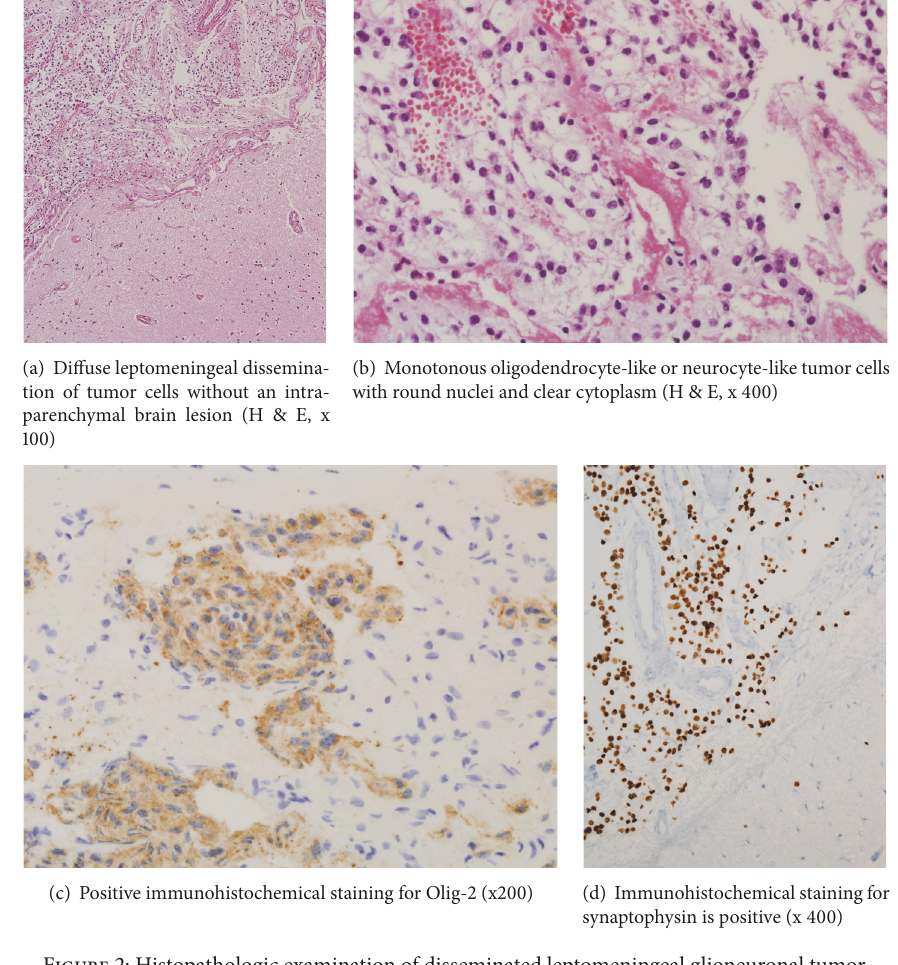
Figure 2: Histopathologic examination of disseminated leptomeningeal glioneuronal